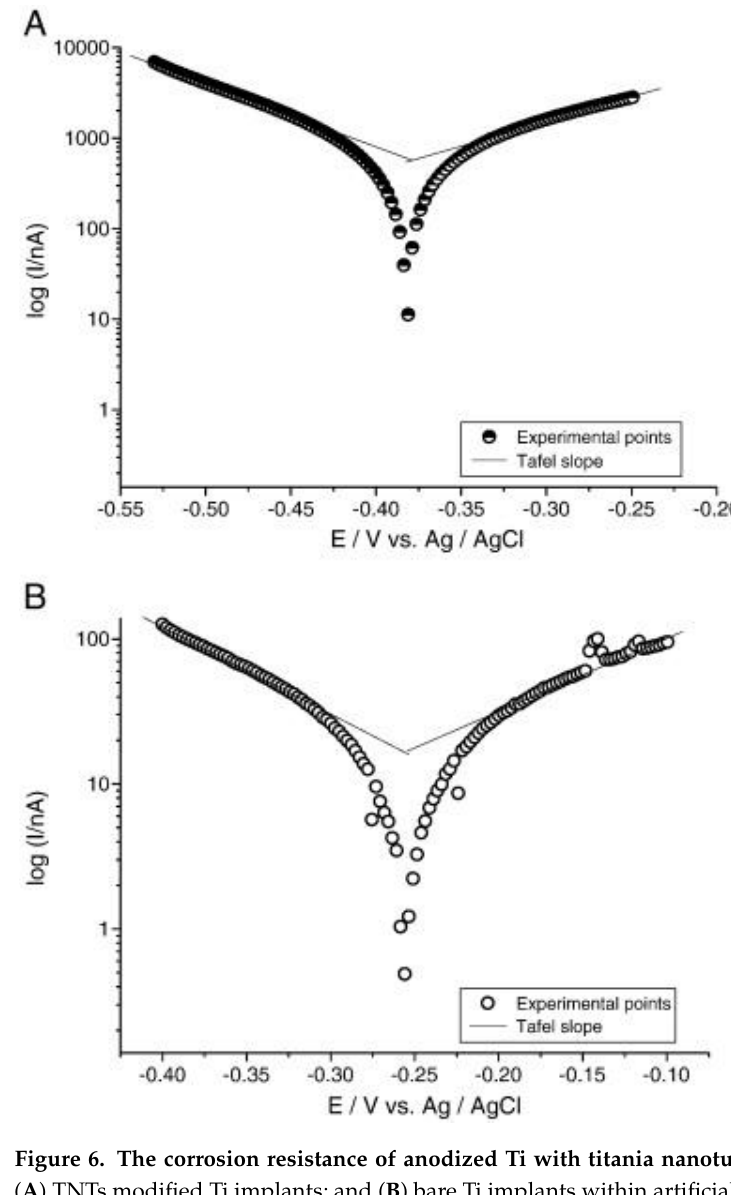
Figure 6. The corrosion resistance of anodized Ti with titania nanotubes (TNTs). Tafel plots of ( A ) TNTs modified Ti implants; and ( B ) bare Ti implants within artificial saliva. Results reveal that corrosion potential (E corr ) of anodized Ti implants was significantly higher than that of the bare Ti. Reproduced with permission from [96].